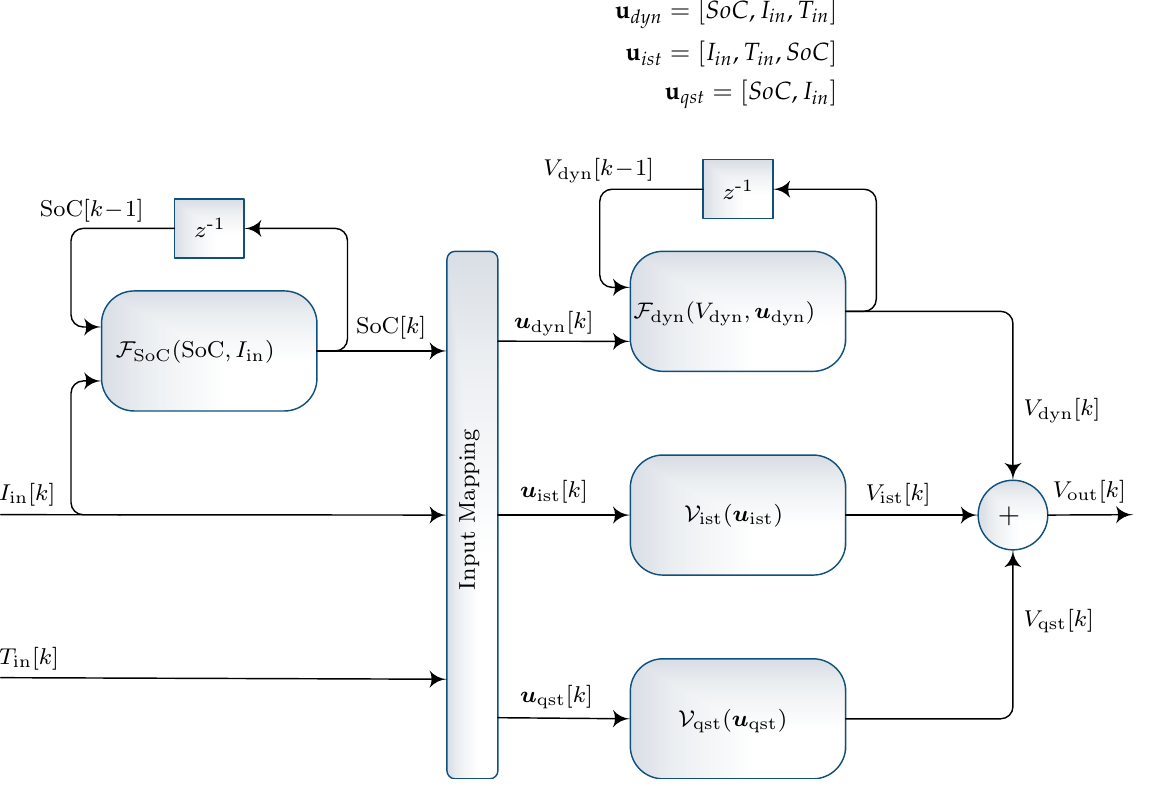
Figure 1. Block diagram of the discrete system for electrochemical cell